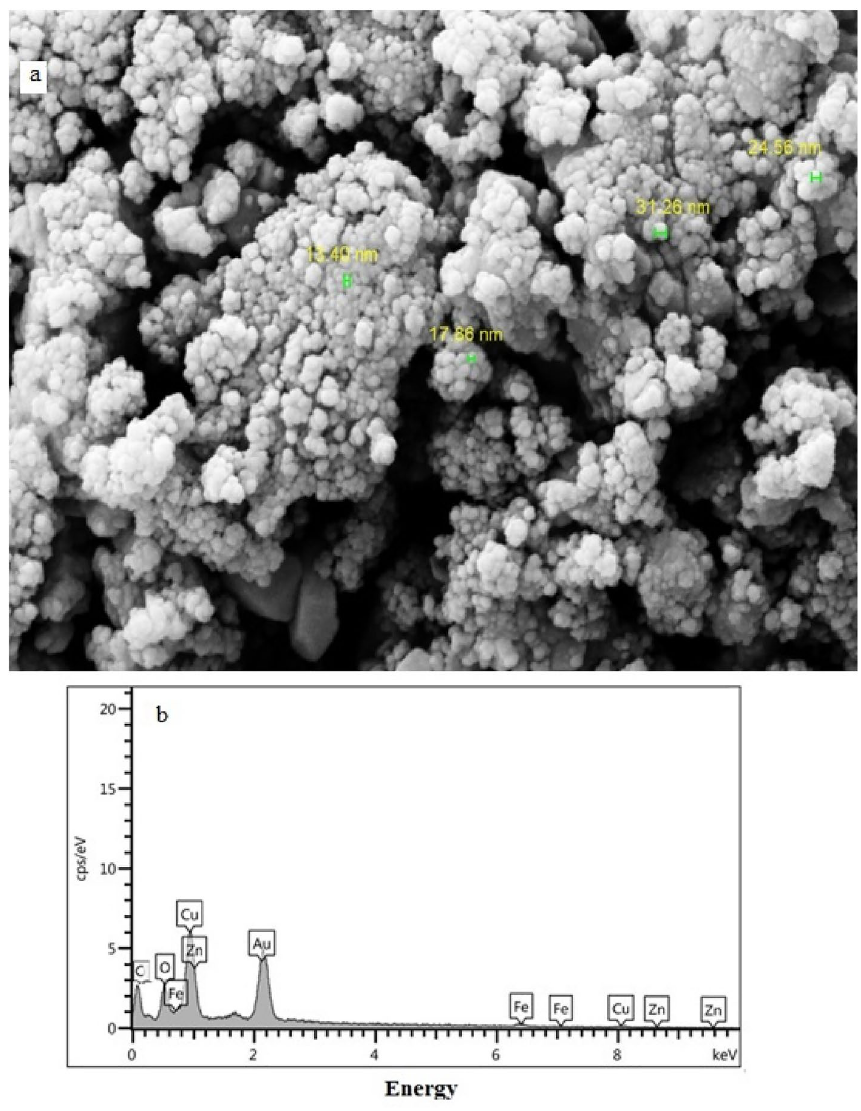
Figure 3. FESEM-EDS analysis: ( a ) SEM image ( b ) EDS diagram of Zn-doped CuFe 2 O 4